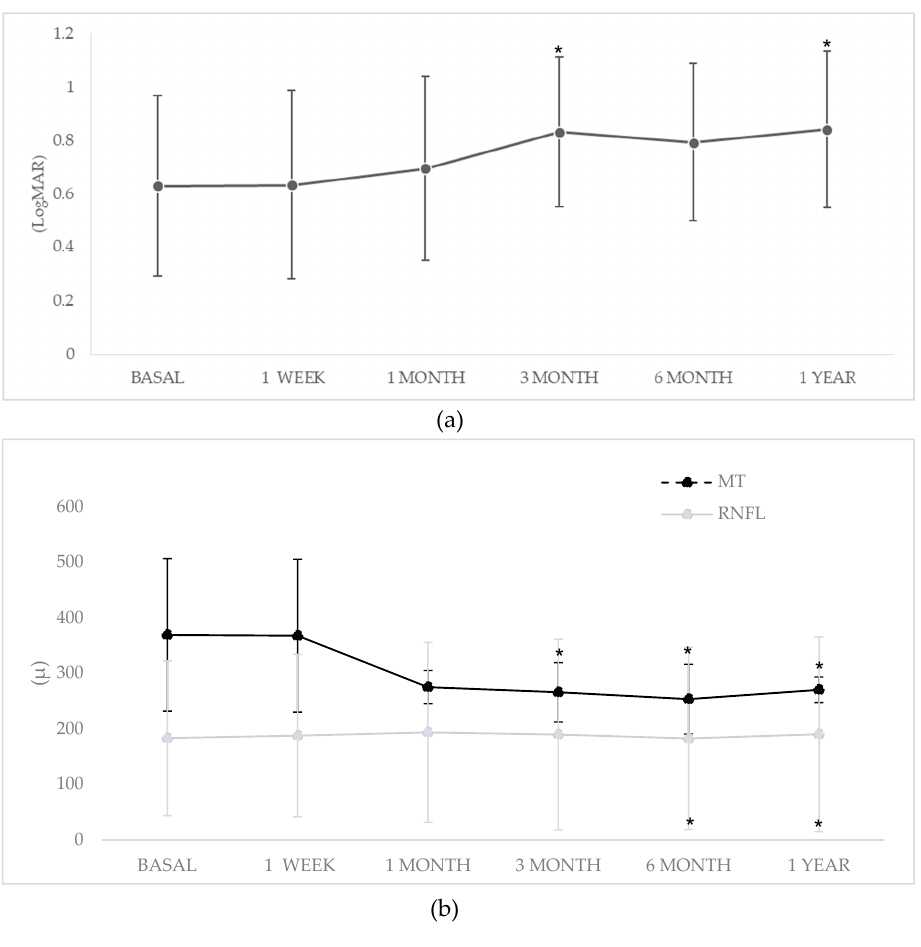
Figure 2. Improvement in ( a ) Best Corrected Visual Acuity (BCVA) and ( b ) Optical Coherence